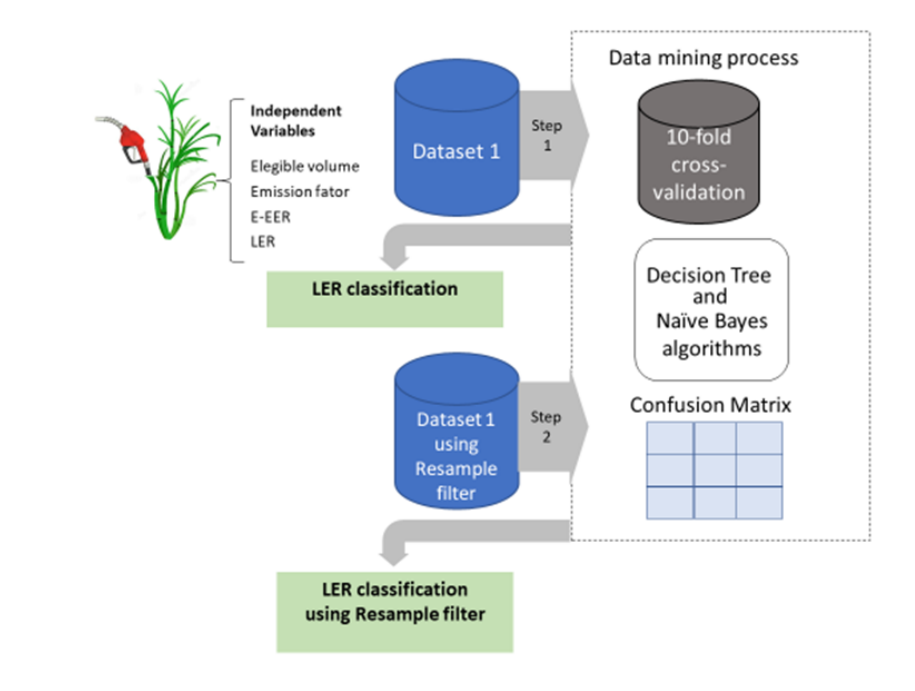
Figure 3. Schematic of the modeling process used to classify the Energy-Environmental E ffi ciency Rating of Brazilian ethanol. E-EER, Energy-Environmental E ffi ciency Rating; LER, Level of E ffi ciency Rating. A classifier is a mapping from unlabeled instances to (discrete) classes. Classifiers have a form (classification tree) plus an interpretation procedure (including how to handle unknown